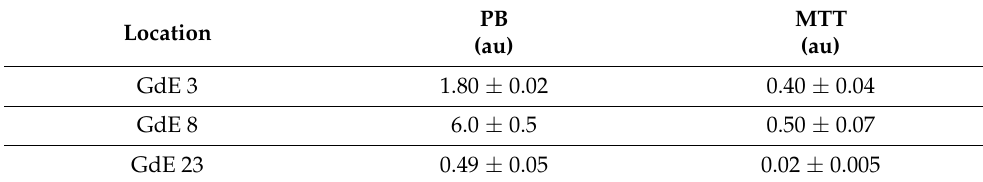
Table 1. Assessment of the biological contaminations inside the Escoural cave by PB and MTT